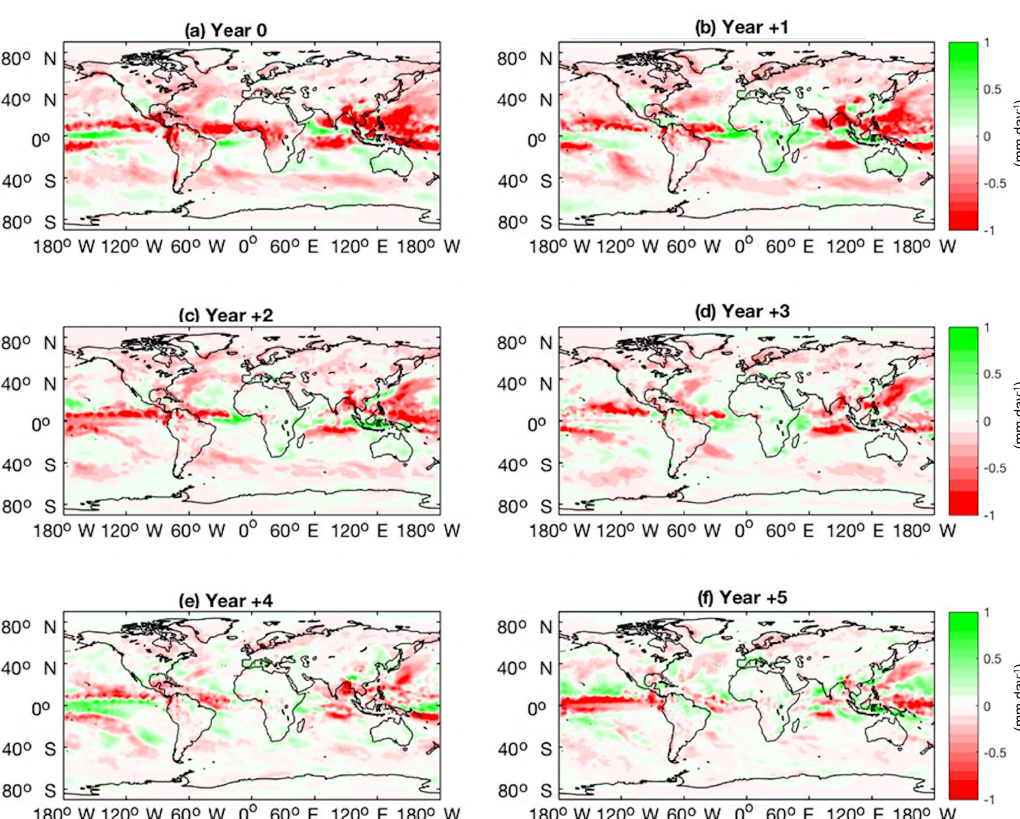
Figure 8. Global precipitation anomalies (mmday − 1 ) in response to the Crowley and Unterman (CR) forcing, showing multi-ensemble mean responses over JASON averaged across all analysed eruptions for years 0 to + 5 after